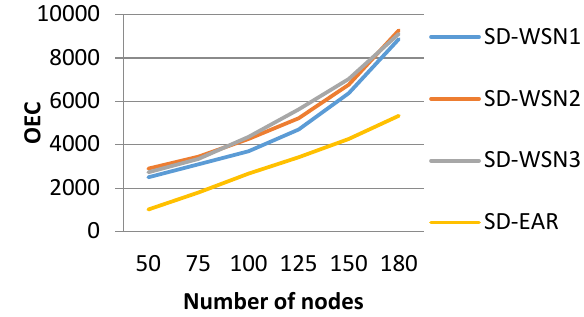
Figure 17. OEC vs. number of nodes.